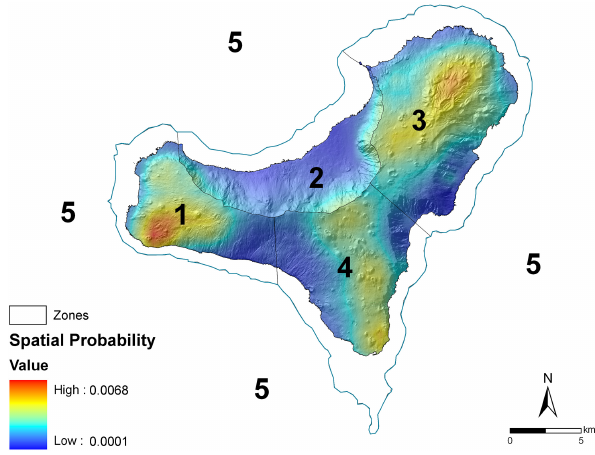
Figure 2. Onshore spatial probability distribution of future volcanic eruptions map of El Hierro Island, showing the divisions of the sec- tors. Modified from Becerril et al.